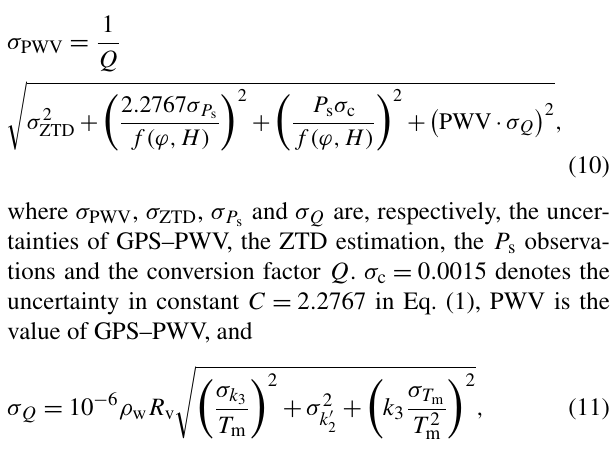
Figure 9. Variation in the uncertainty in Q with the value of T m and the uncertainty in T m .